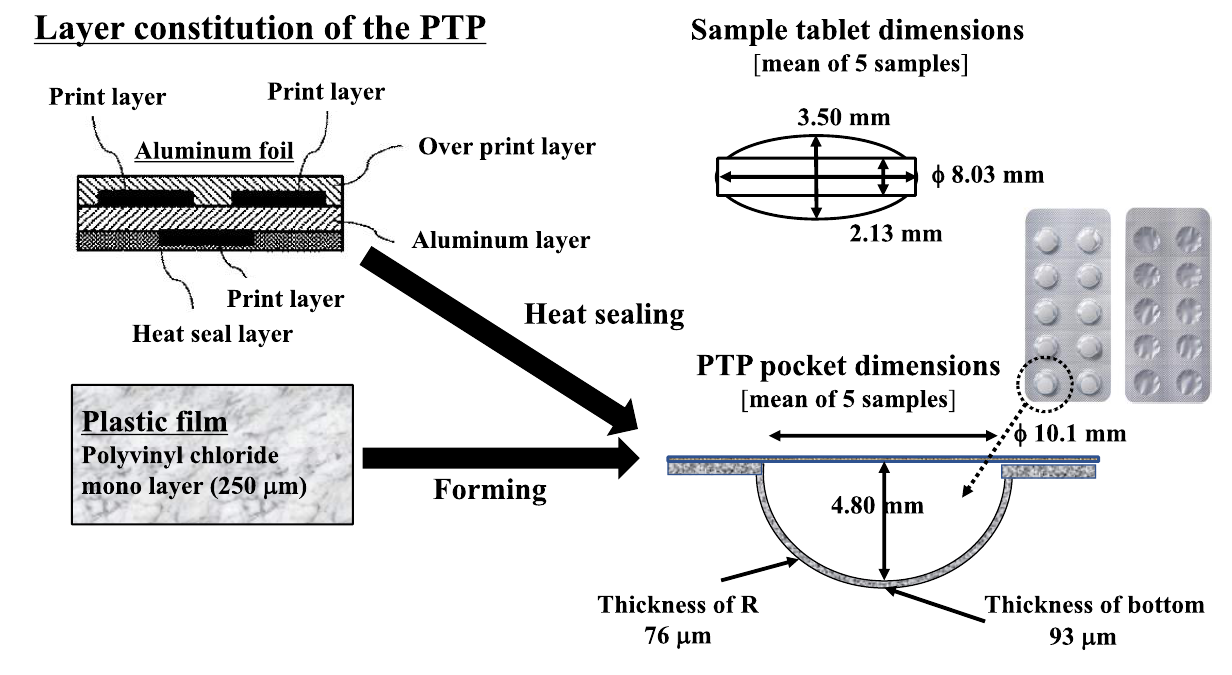
Figure 1. PTP materials and size of tablets and PTP